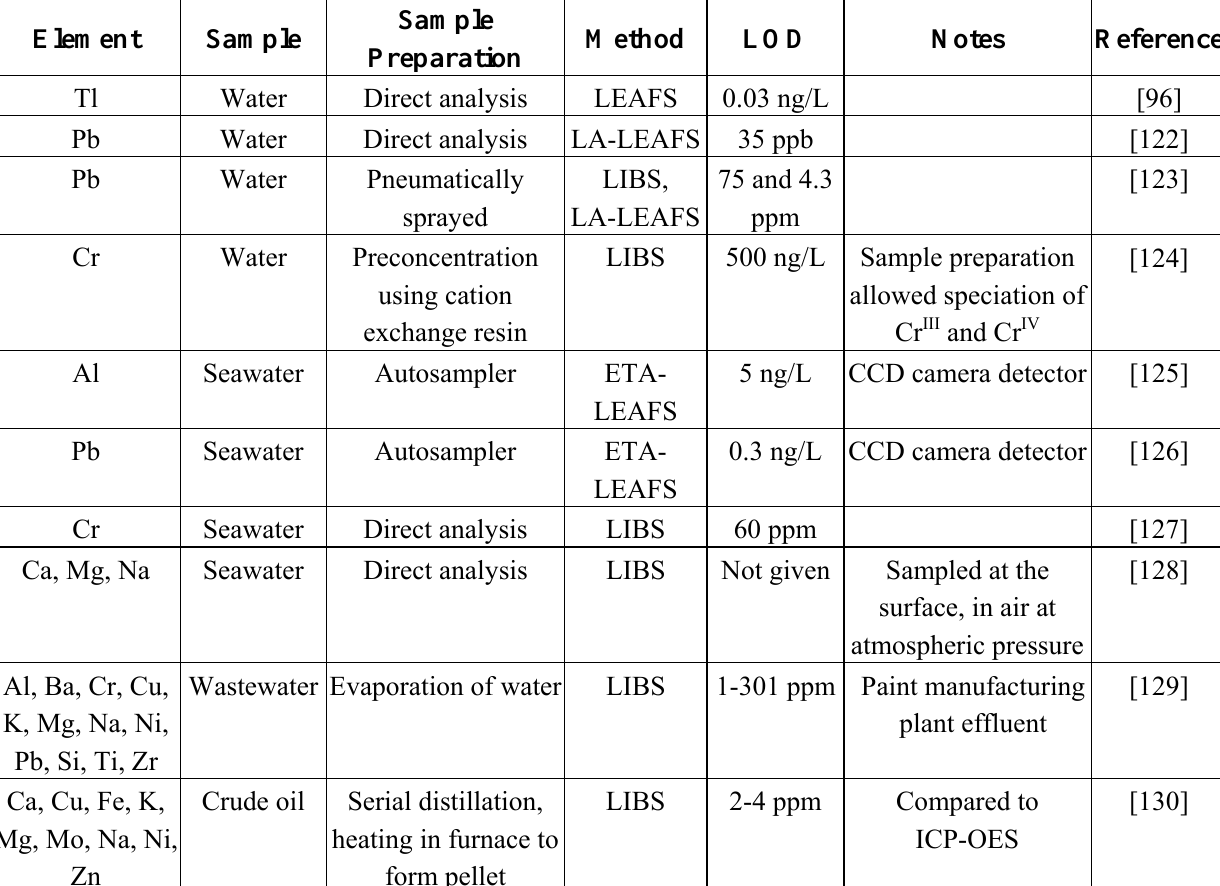
Table 2. Laser-based spectroscopic applications to environmental